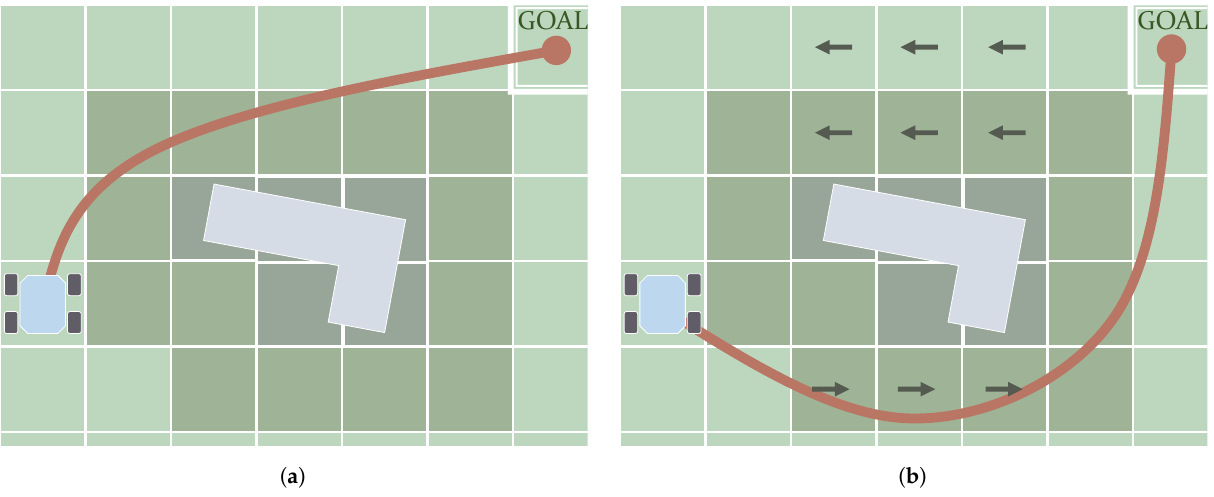
Figure 11. PDE-Solving -based algorithms can calculate a continuous and smooth path in non-uniform cost maps. The cost assigned to each cell can be a scalar value or isotropic ( a ) or in the form of a vector, i.e., anisotropic ( b